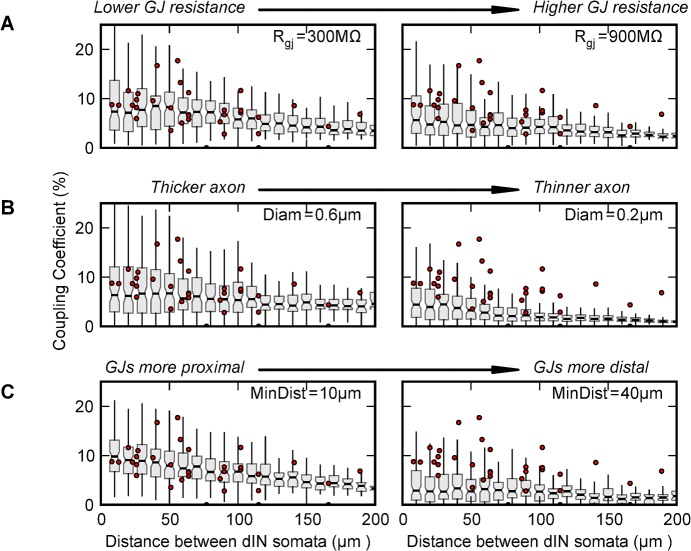
The effects of different parameters on the coupling coefficients measured between neurons in a passive population model.In (A-C) a single parameter is varied (two values are shown) and the coupling between model neurons at different distances was measured for 100 generated networks for comparison with the coupling between pairs of dINs measured experimentally (shown by dots in each graph; [29]). The notched grey bars show the median and 25% to 75% quartiles of the model coupling coefficient at each distance. The lines represent the 5% to 95% percentiles. Starting parameters (see text): Ri = 80 Ωcm, RGJ = 600 MΩ, min-dist = 20 μm, max-dist = 70 μm, glk = 0.25 mS cm-2 and axon diam = 0.4 μm. In each case the visual match to experiments is better in the left column than in the right column. (A) RGJ reduced from 600 to 300 MΩ or increased to 900 MΩ. (B) Axon diameter increased from 0.4 to 0.6 μm or reduced to 0.2 μm. (C) Minimum distance from the caudal soma was reduced from 30 to 10 μm or increased to 40 μm. The parameters min-dist and max-dist correspond to the left and right-hand edges of the GJ distribution step in Fig 2D respectively. When gap junctions were distributed closer to the somata of the neurons, the coupling was stronger (in part because there are more gap-junctions in the network in total).